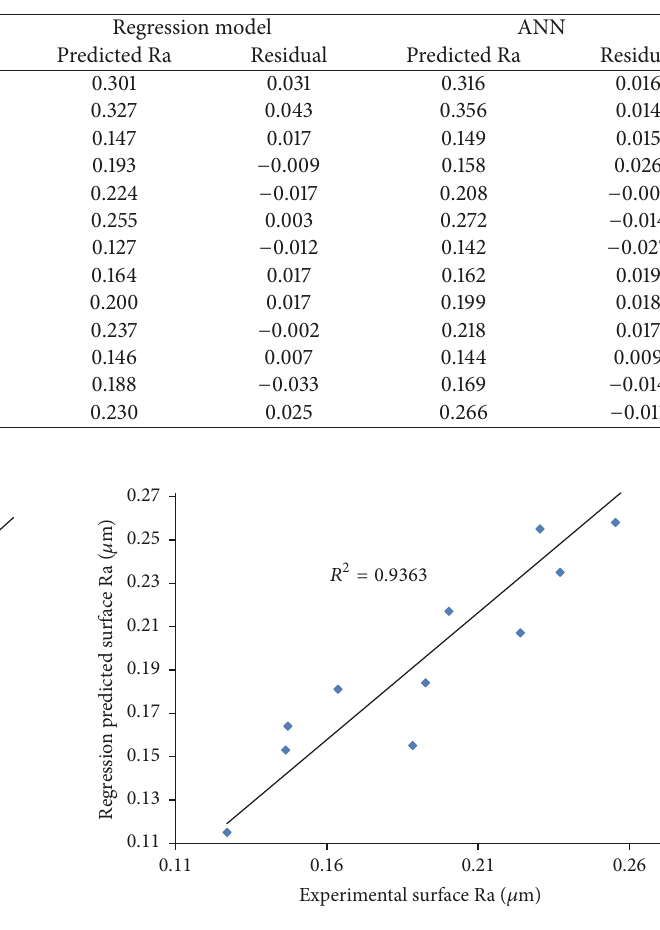
Figure 5: Experimental and regression predicted